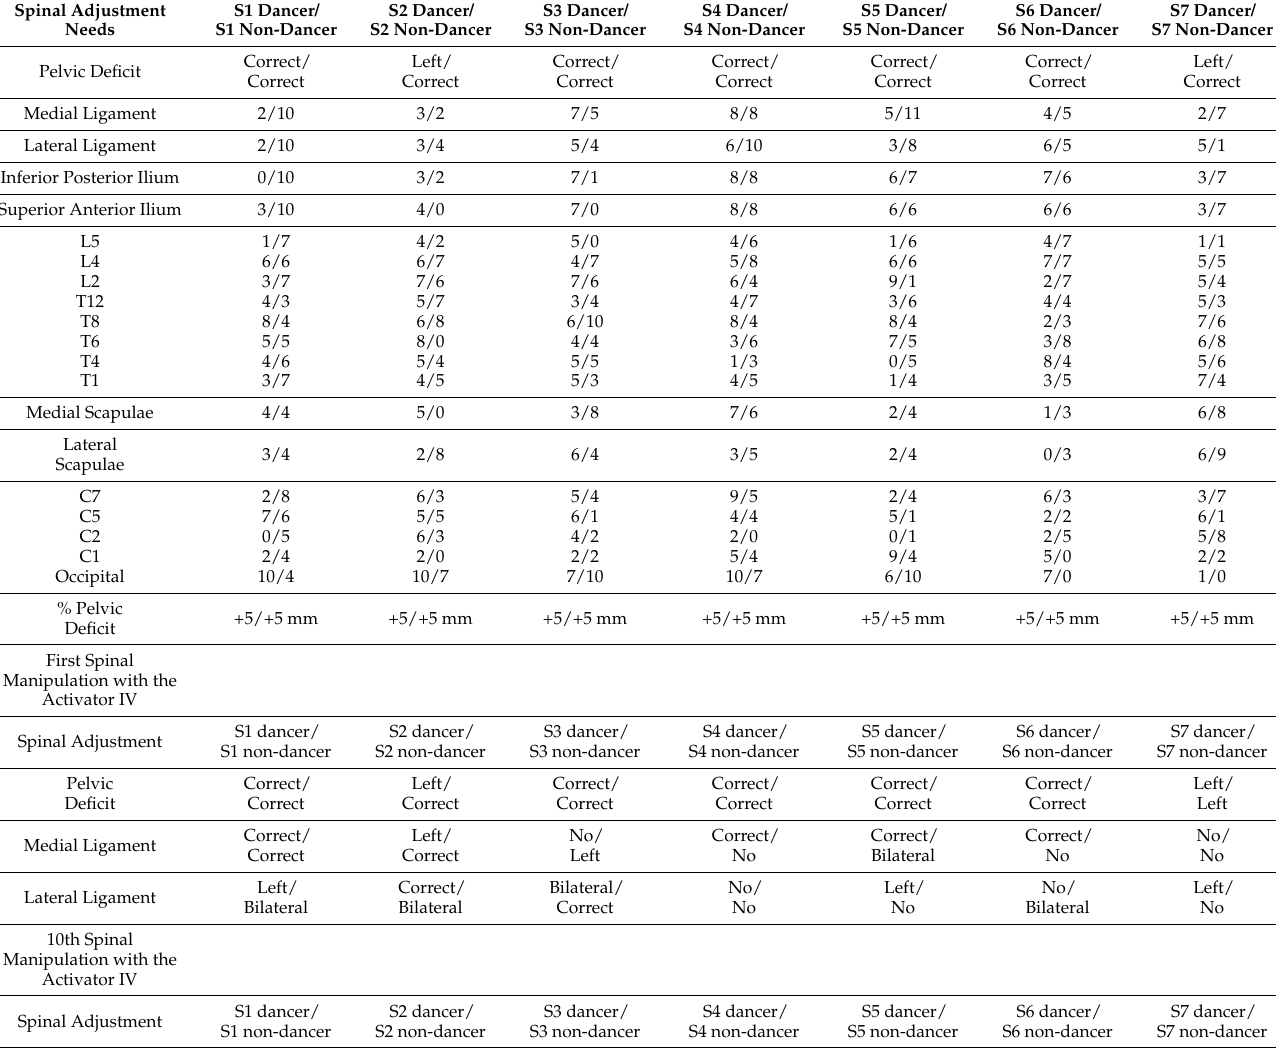
Table A2. Spinal manipulations performed on dancers and